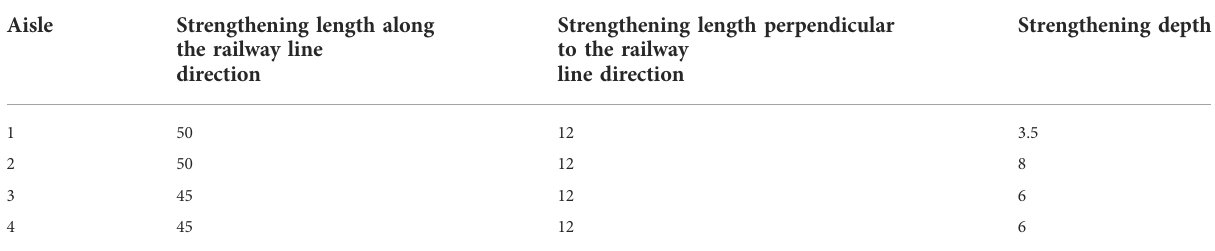
TABLE 2 Subgrade grouting scope (m). Aisle Strengthening length along the railway line direction line